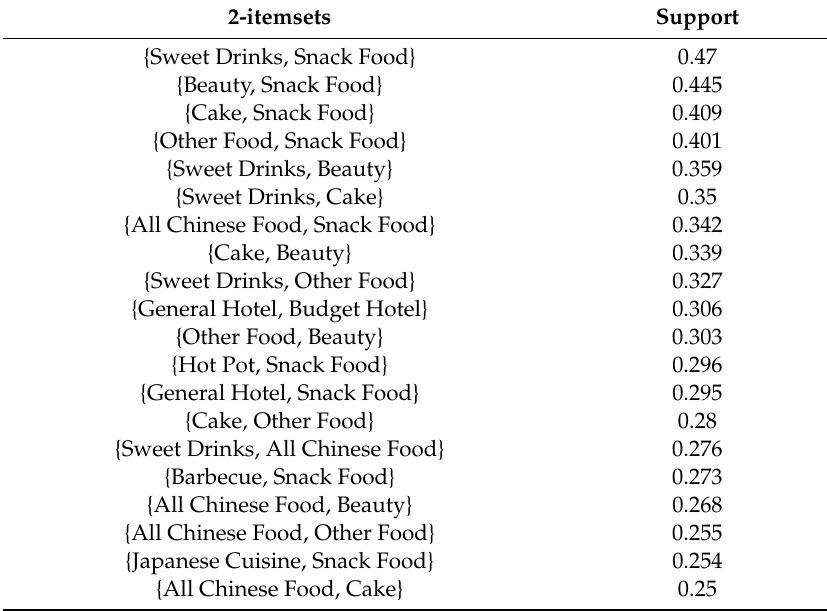
Table 3. Top 20 2-frequent closed itemsets and 3-frequent closed itemsets of the urban service industry in Nanning city,